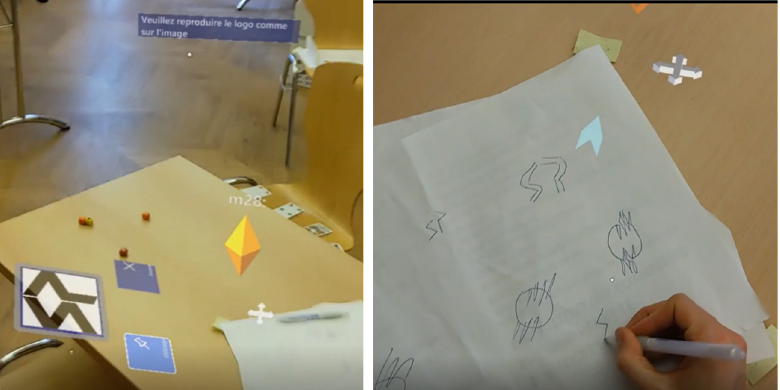
Figure 3. User view of the task at hand. The left image shows the task setup, with the instruction and explicative media displayed at the task location which is indicated by an orange gem. The right image shows the user performing the task with the permanent 3D arrow blinking in his or her field of view.